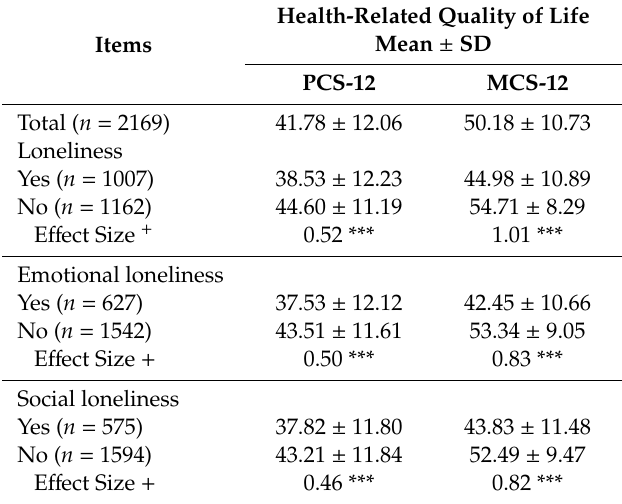
Table 3. Health-Related Quality of Life of the study population stratified by loneliness. Health-Related Quality of Life Mean ± SD Items